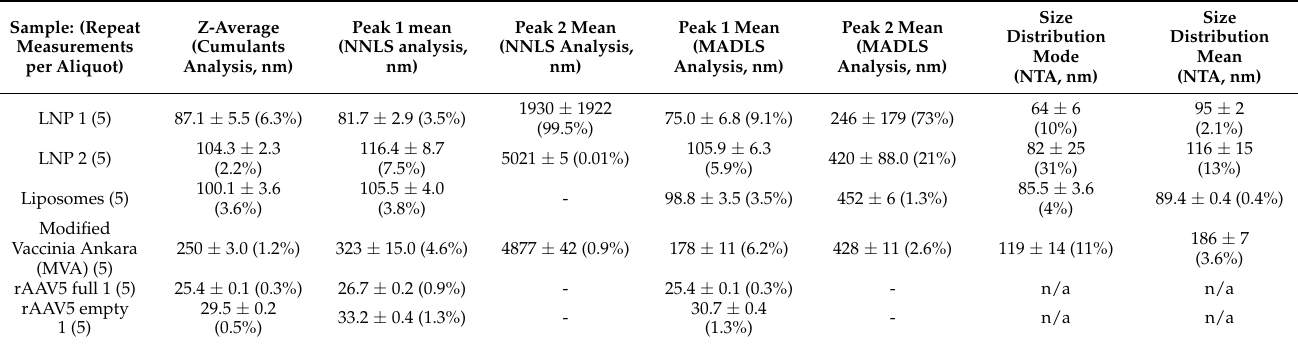
Table 4. Summary of size results for viral and non-viral vectors. Numbers between brackets are relative standard deviation RSD). NTA is not applicable (n/a) for rAAV5 samples due to their small size. When no second peak is identified “-” is